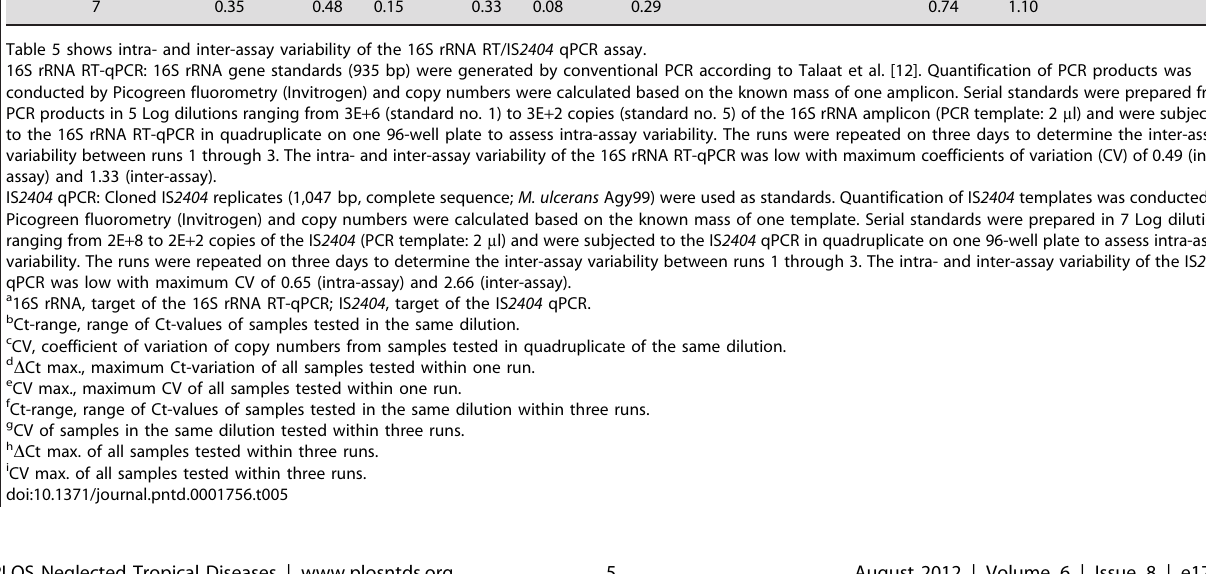
qPCR Target a Standard No. Run No.